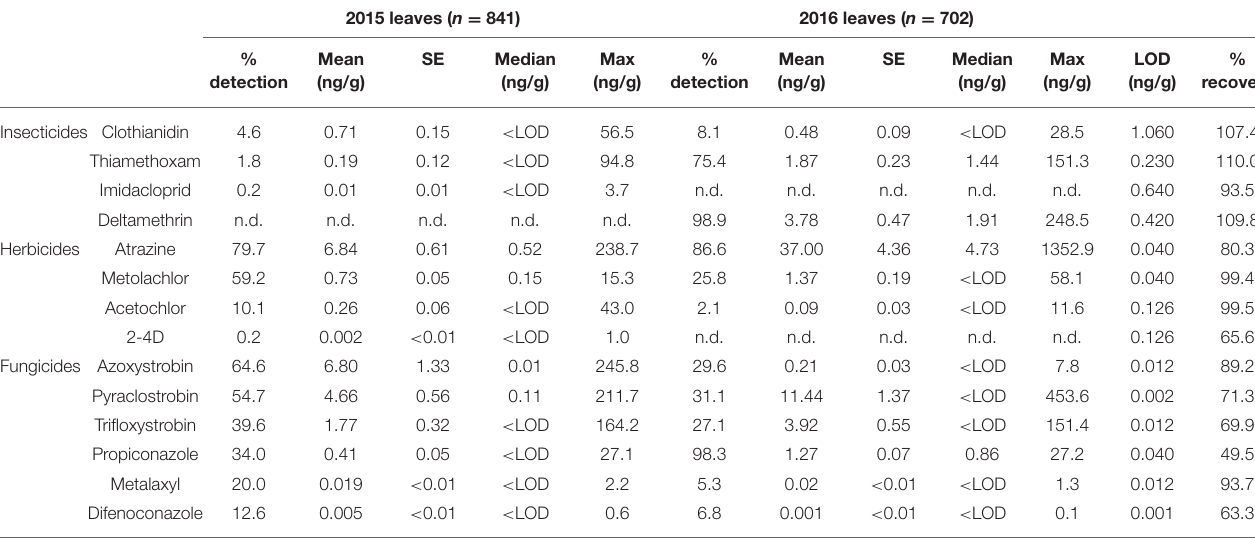
TABLE 3 | Summary data for pesticides detected in milkweed leaf samples across both years of the study.